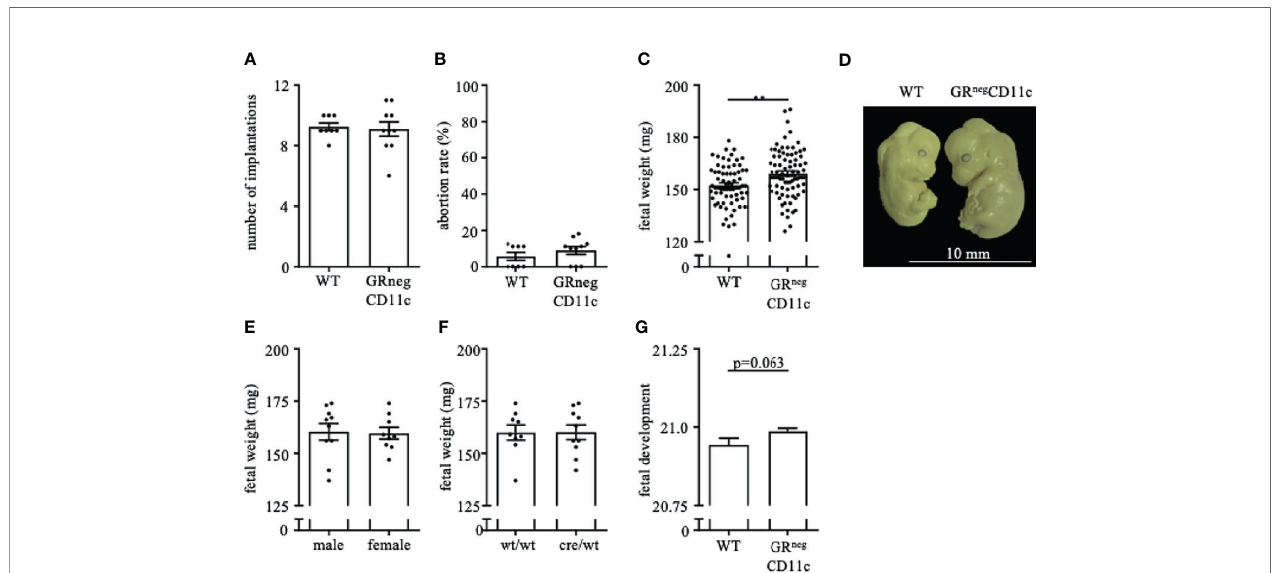
FIGURE 2 | Selective knockout of the GR on CD11c + dendritic cells results in improved fetal outcome. WT and GRnegCD11c female mice were allogenically mated to Balb/c males and pregnancy outcome was assessed on gestational day (gd) 13.5, maternal phenotype is always indicated below: number implantation (A) , abortion rate (B) and fetal weight (C) . A representative picture from gd 13.5 fetuses of WT (left) and GRnegCD11c (right) mice is shown in (D) , white line in the picture denotes 10mm. Fetal weight of fetuses from GRnegCD11c dams is further shown dependent on fetal sex (E) and fetal genotype (F) . (G) Fetal development was scored on gd13.5 according to Theiler criteria. Scatter-bar-plots represent mean ± SEM, Student ’ s t test, **p ≤ 0.01. Each dot in the scatter plot represents a single